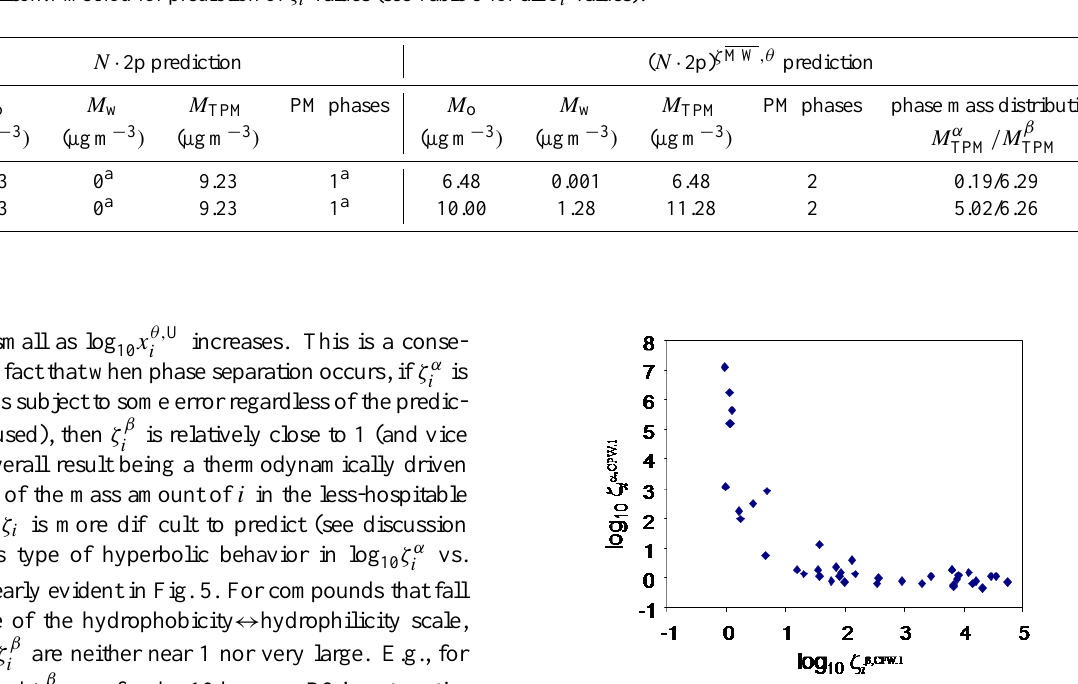
Fig. 5. Hyperbolic relationship between log 10 ζ α culated in the performance evaluation (PE) case by the CP-Wilson.1